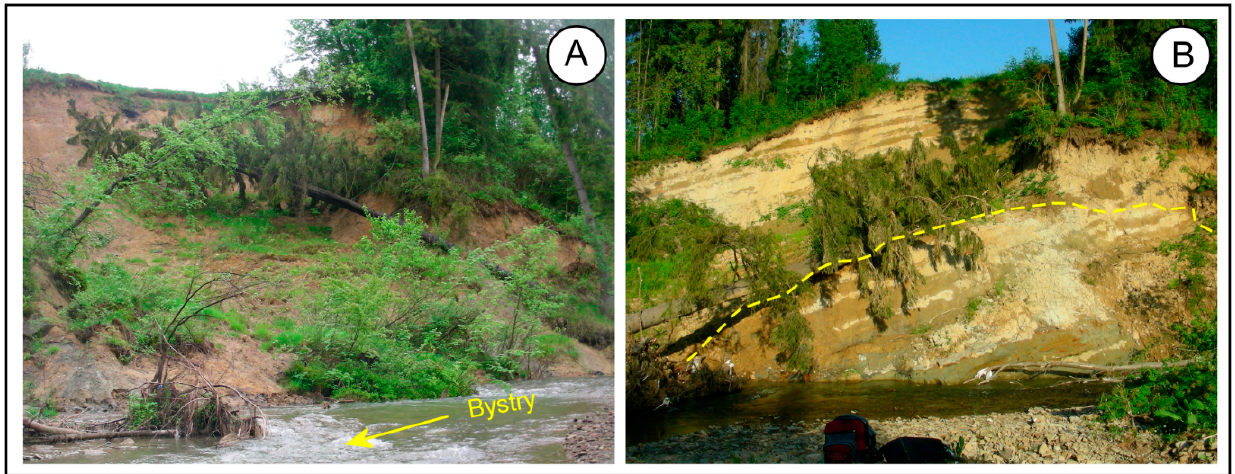
Figure 4. Lud´zmierz landslide (site 2) being undercut by the Wielki Rogo´znik: ( A )—gravel in the escarpment of the landslide, ( B )—landslide surface. Figure 4. Lud ź mierz landslide (site 2) being undercut by the Wielki Rogo ź nik: ( A )—gravel in the escarpment of the landslide, ( B )—landslide surface.